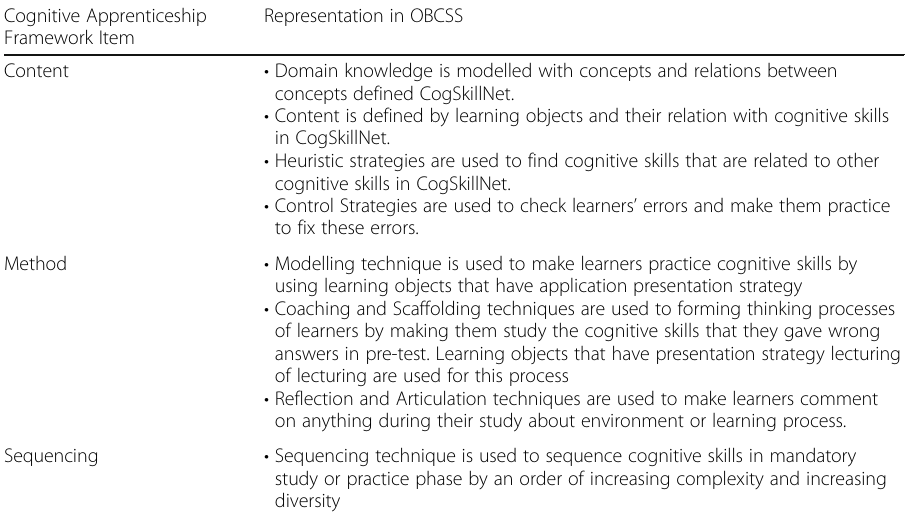
Representation in OBCSS